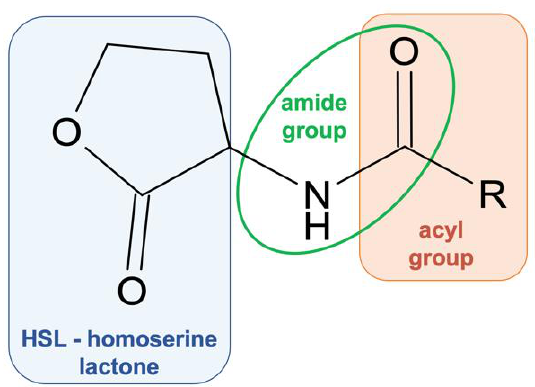
Figure 3. General structure of N -acyl-homoserine lactones.